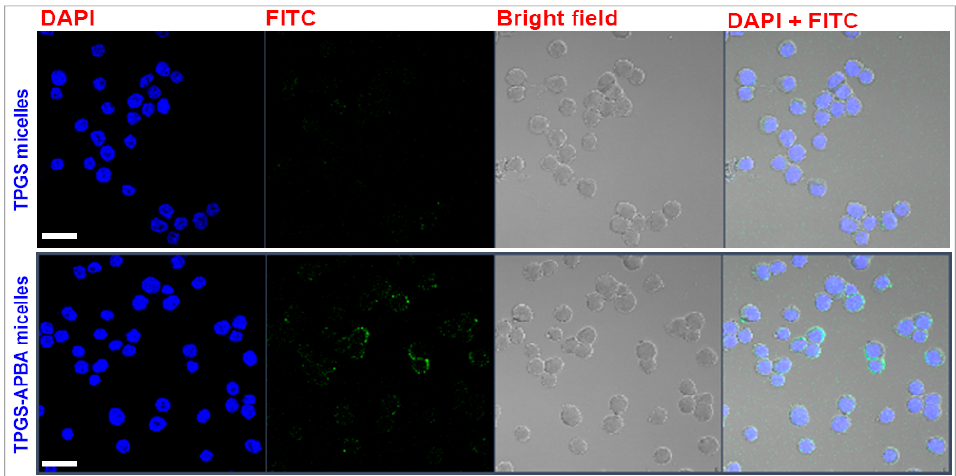
Figure 6. Comparison in the cellular uptake of micelles composed of TPGS (upper panel) and TPGS-APBA (lower panel). Cells were incubated with FITC-loaded micelles for 4 h prior to imaging. (nuclei—blue, micelles—green). The scale bars represent 10 µm.